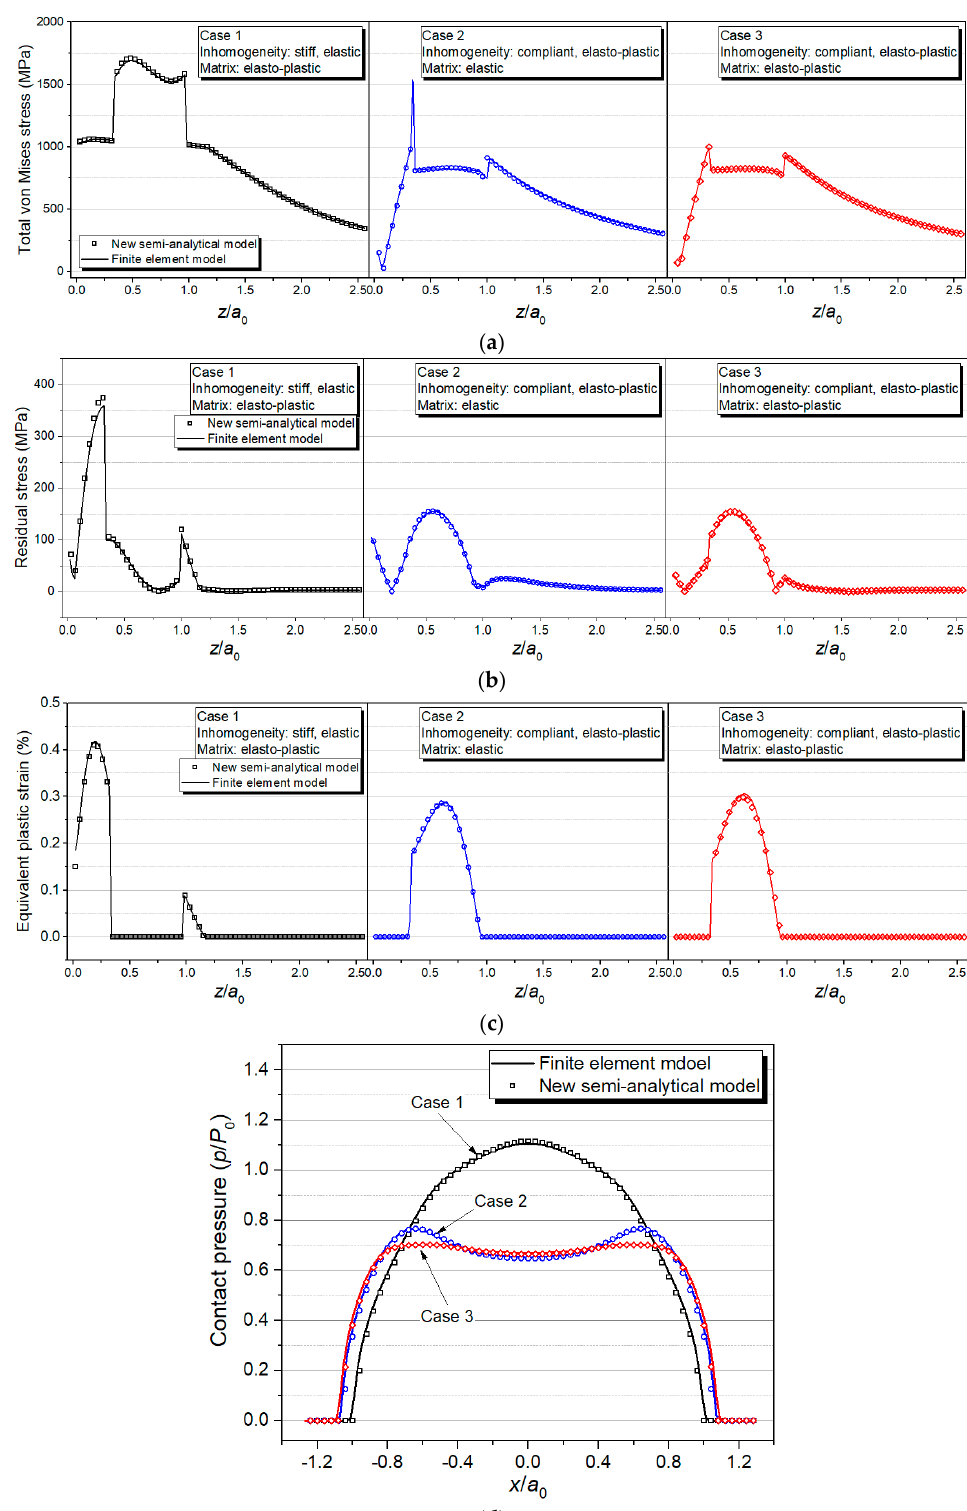
Figure 11. Detailed comparisons of the results of FEM and SAM along the z -axis or the x -axis: ( a ) total von Mises stress, ( b ) residual von Mises stress, ( c ) equivalent plastic strain, and ( d ) contact pressure.